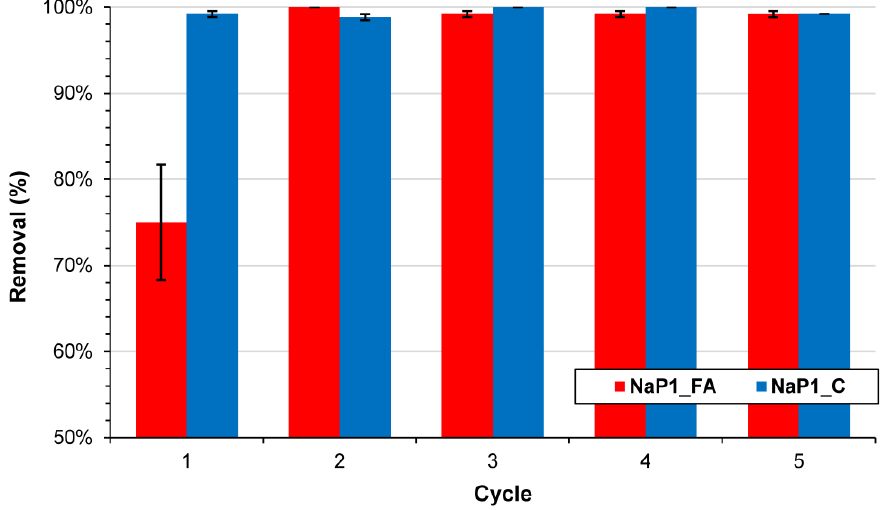
Figure 9. The EA removal efficiency of NaP1_FA and NaP1_C after regeneration cycles.